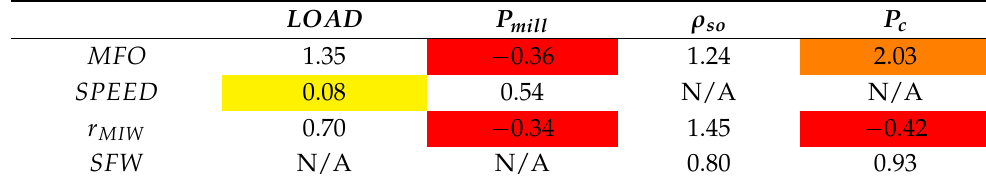
Table 3. Ratio of gains between the DQA and planned step test models. Red background—negative; Orange background—greater than two; Yellow background—positive, less than